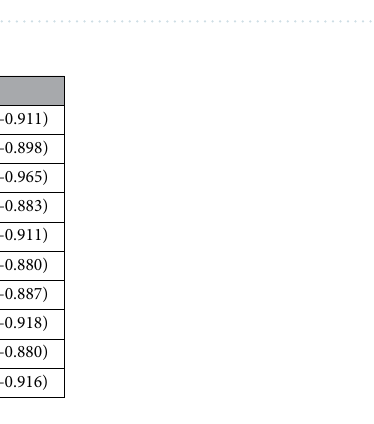
Table 3. Evaluation of model fitness in training and test